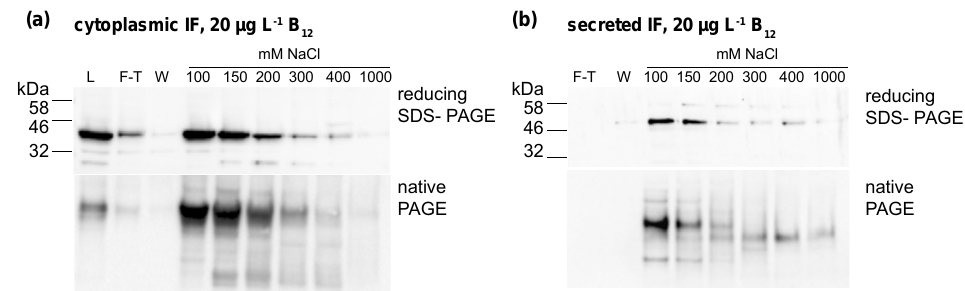
Figure 4. Protein fractions purified from ( a ) cellular lysates (human intrinsic factor (IF) strain) and ( b ) medium (ars-IF strain) HA-Immunoblots of reducing SDS- and native-PAGE show the presence of the IF protein in the separate fractions. L-lysate; F-T—flow-through; W-wash fractions (wash 1 and wash 2 as shown in Figure 4 were pooled); 100 mM–1000 mM: NaCl concentrations of eluted fractions.